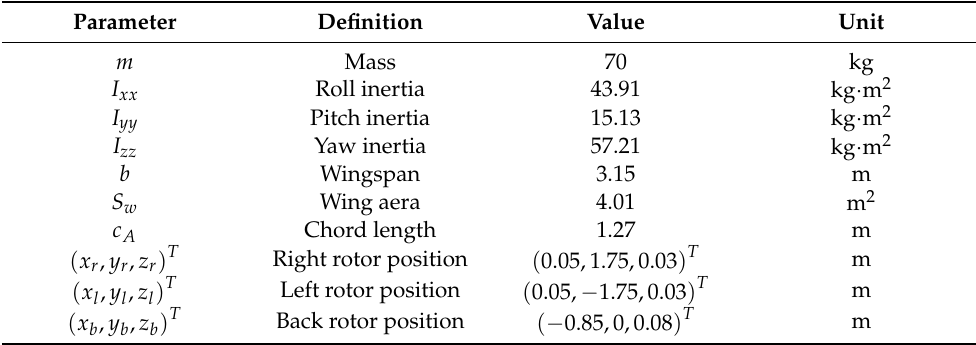
Table 2. The model parameters of the novel tilt-rotor UAV.